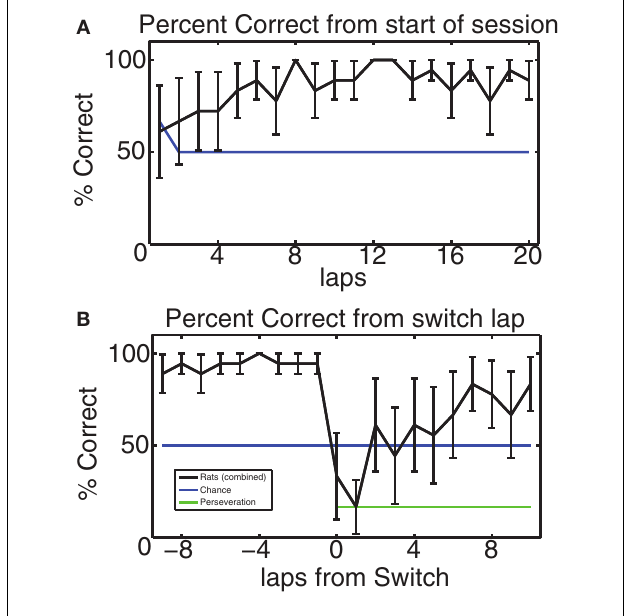
FIGURE 4 | (A) Average percent of correct laps over all switch sessions aligned to start of the session. Blue line indicates chance rate of responding. Because the first lap of the alternating contingency was always rewarded, chance is 66% on the first lap, but 50% after that. Rats started at chance and quickly learned to make correct choices. (B) Percent of correct laps aligned to the switch. On the switch lap, percent-correct dropped to the expected level given no knowledge of the oncoming switch, but then rose back up to above-chance levels. Blue line indicates chance level of behavior, green line indicates perseveration level.